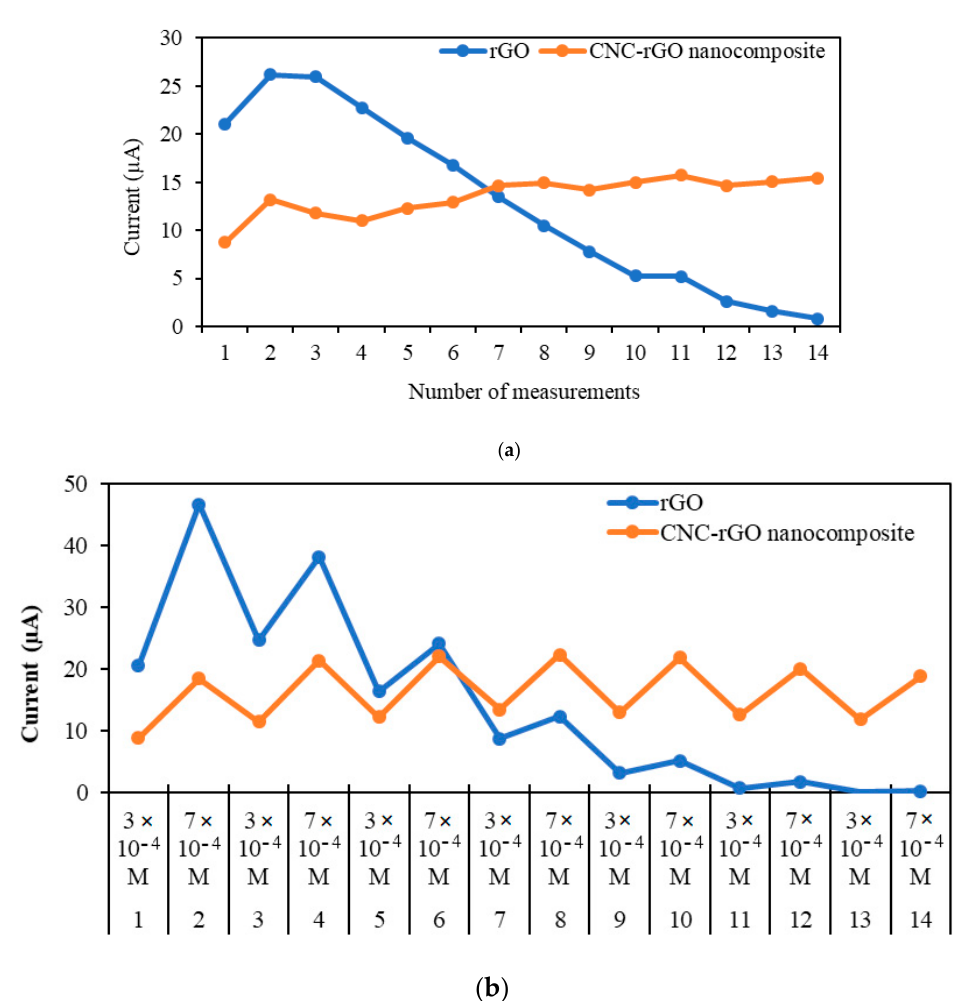
Figure 7. Repeatability study ( a ) rGO and CNC–rGO nanocomposite modified electrodes for 14 consecutive measurements in 3 × 10 − 4 M MP, and ( b ) using one single electrode alternating between 3 × 10 − 4 and 7 × 10 − 4 M MP for rGO and CNC – rGO nanocomposite. All measurements were fixed at 0.75 V.